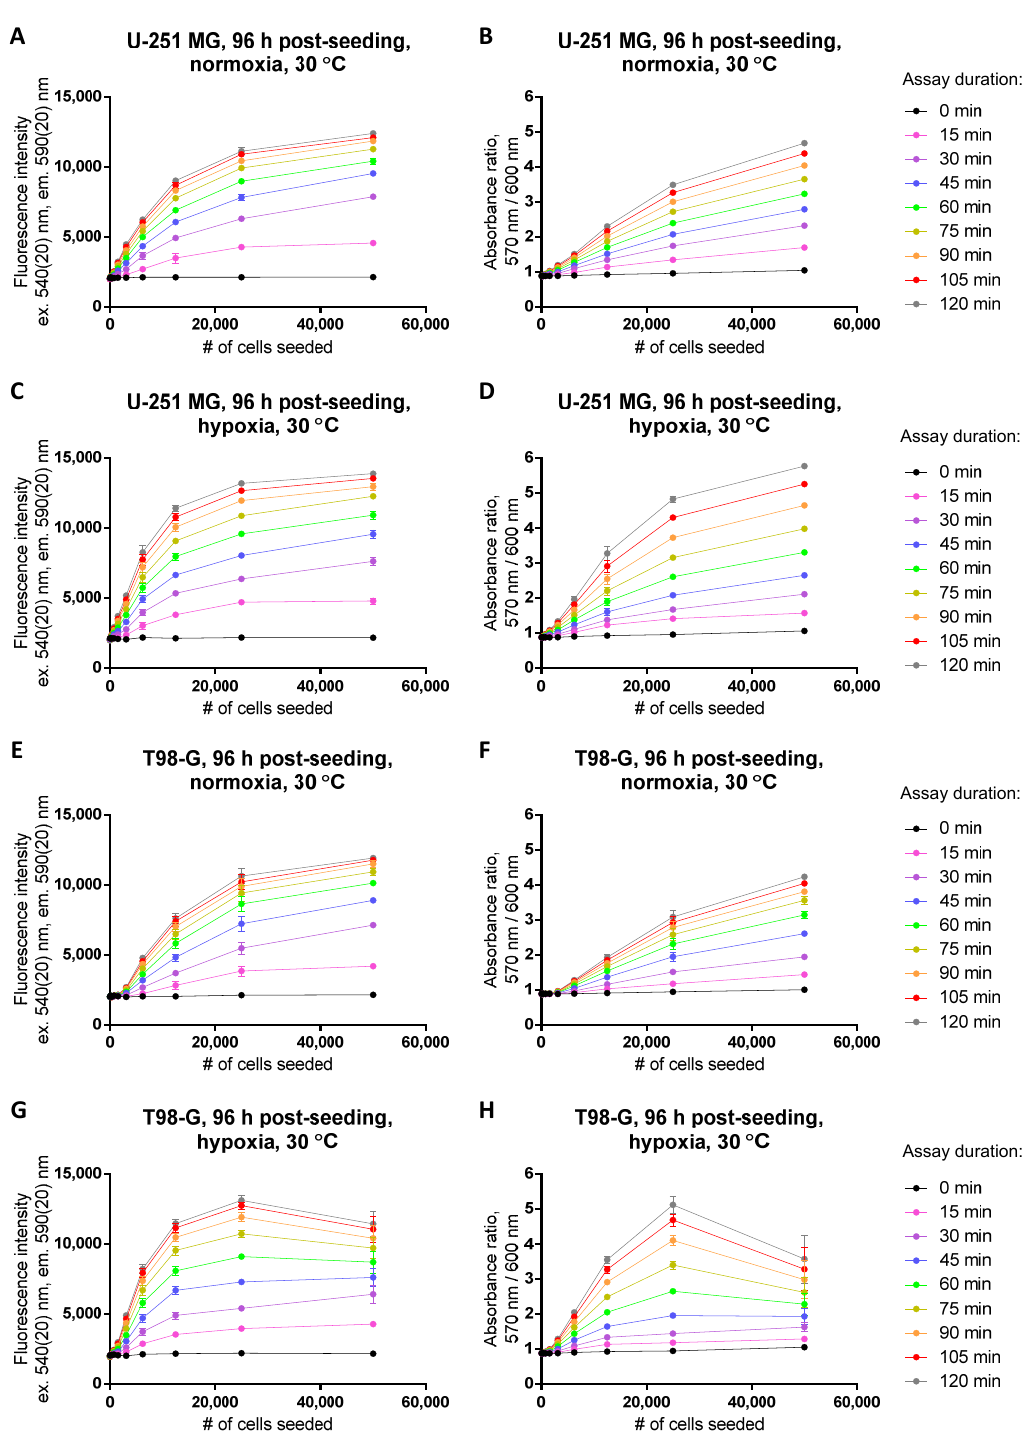
Figure 6. Establishment of the dynamic range in the resazurin assay following normoxic ( A , B , E , F ) vs. hypoxic treatment ( C , D , G , H ) at 30 ◦ C in glioblastoma cell lines ( A – D , U-251 MG; E – H , T98-G). For hypoxic treatment, cells were kept in hypoxic chamber (1% O 2 ) for 72 h prior to measurement of viability (at 96 h post-seeding). Detected optical characteristic: fluorescence intensity (excitation at 540 nm) in ( A , C , E , G ); absorbance ratio (570 nm/600 nm) in ( B , D , F , H ). Measurements were carried out at 50 µ M resazurin (incubation times with resazurin indicated in the legend on the right). In each graph, the average of duplicates or triplicates ± SEM from a single representative experiment is shown.